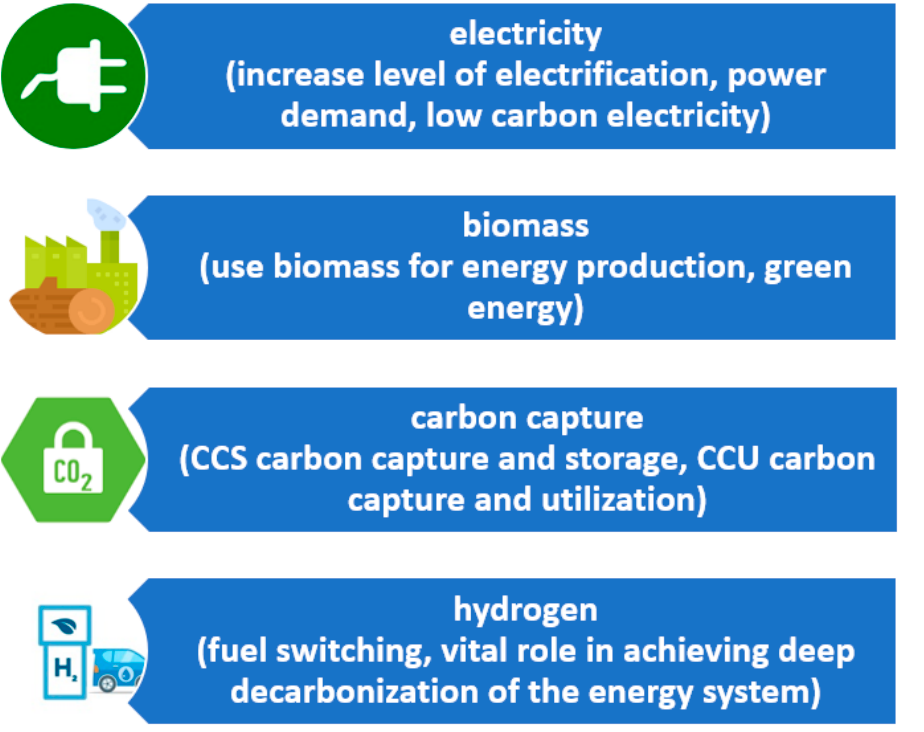
Figure 1. Four main areas of action to achieve zero emissions economy. Source: own elaboration based on [1,4,6,10].